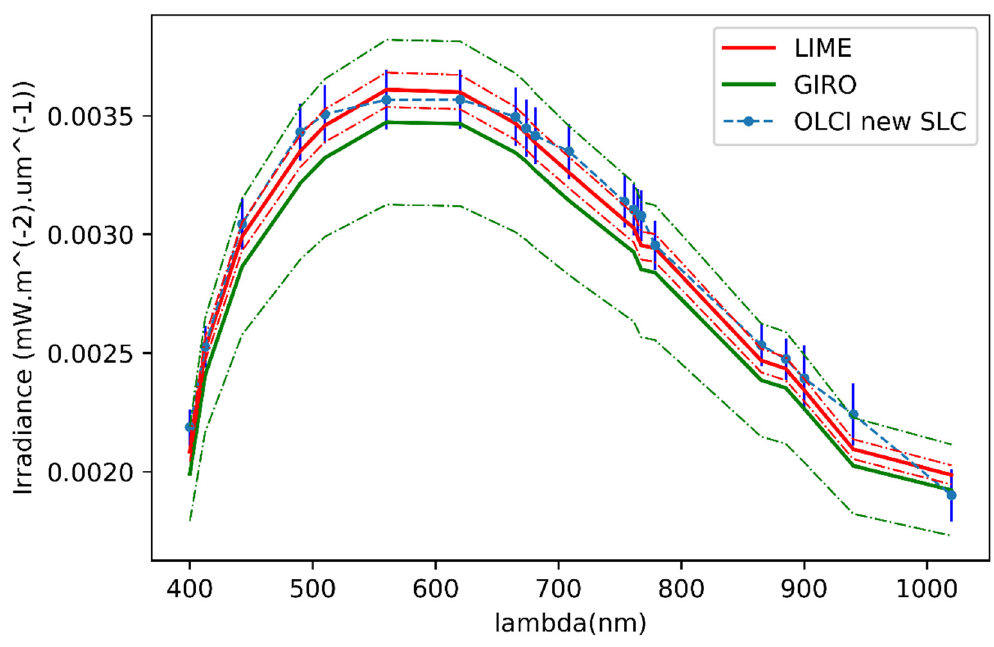
Figure 12. Comparison of absolute irradiance at satellite level with Lunar Irradiance Model ESA (LIME) and GSICS Implementation of Robotic Lunar Observatory (GIRO) models. Dash–dot envelopes indicate expected uncertainty ranges of the model.